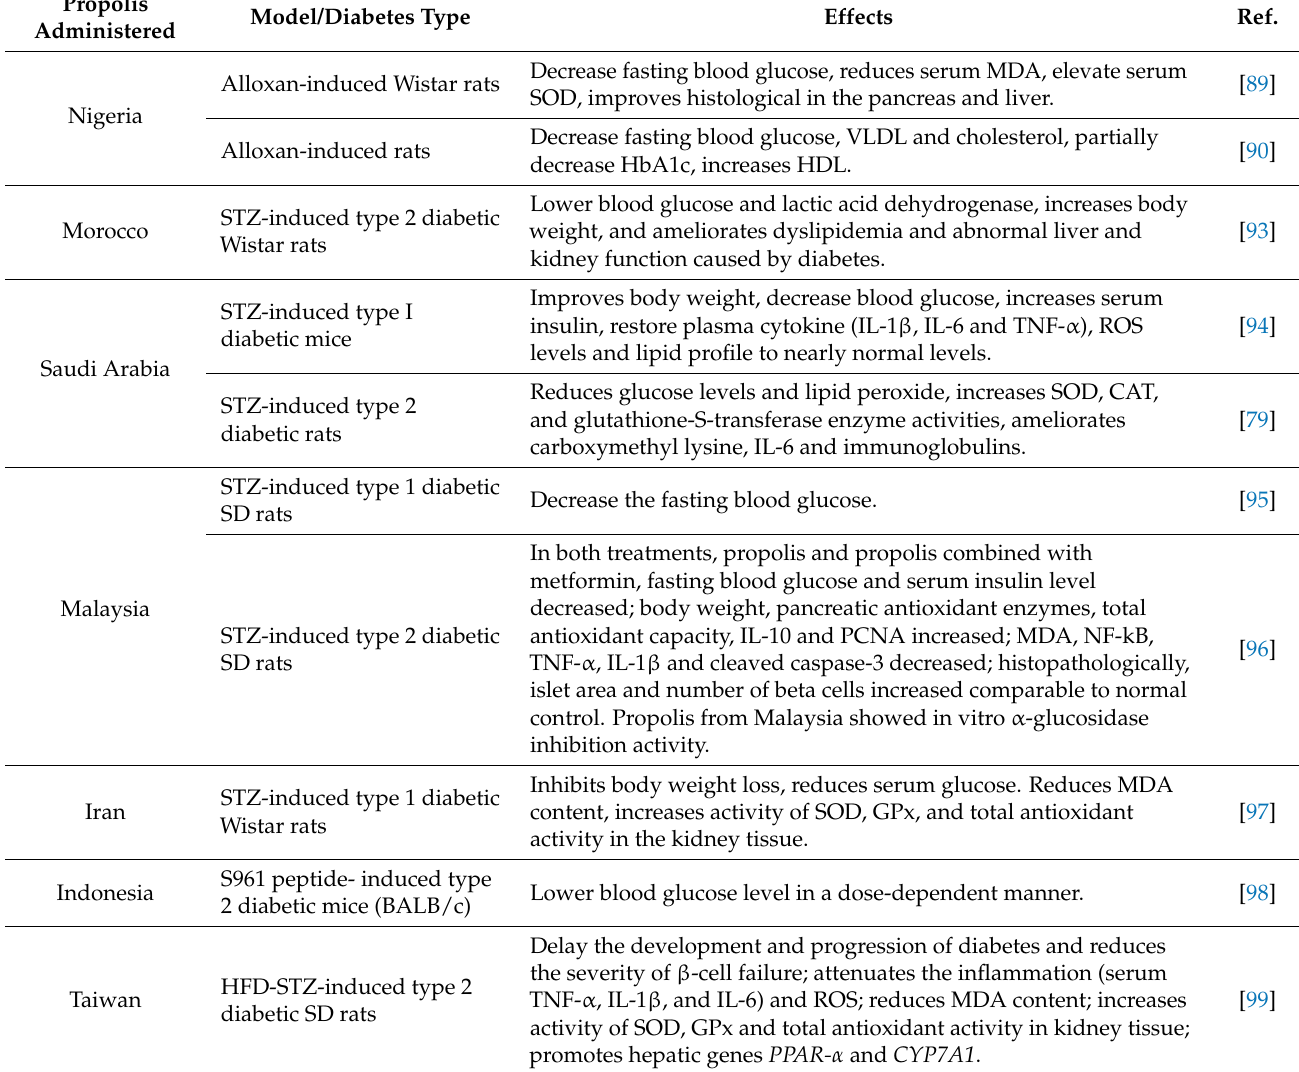
Table 2. Propolis activity in different models of experimental